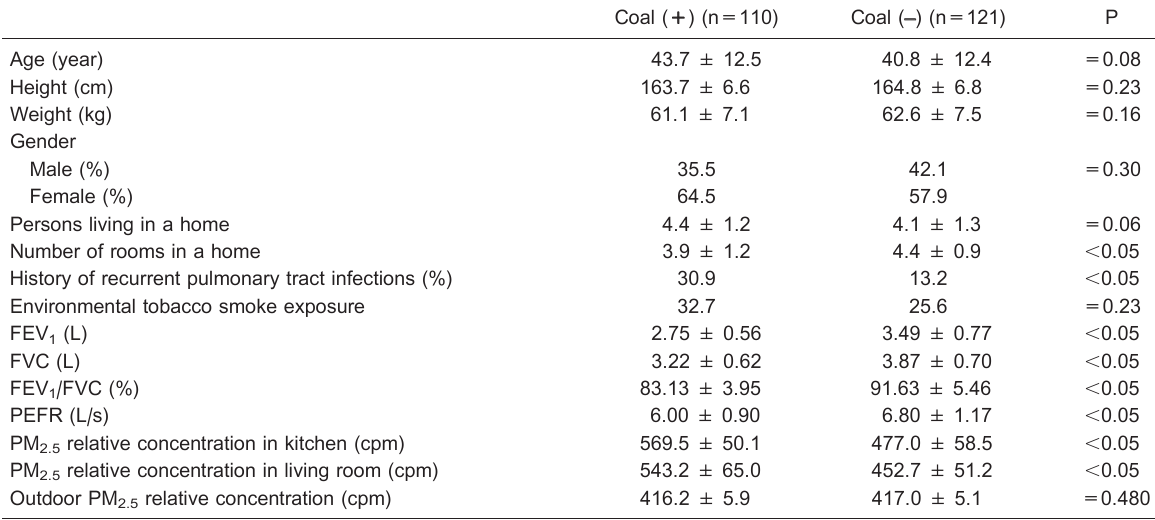
Table 1. Demographic and social characteristics, and values for pulmonary function measurements by coal exposure status.